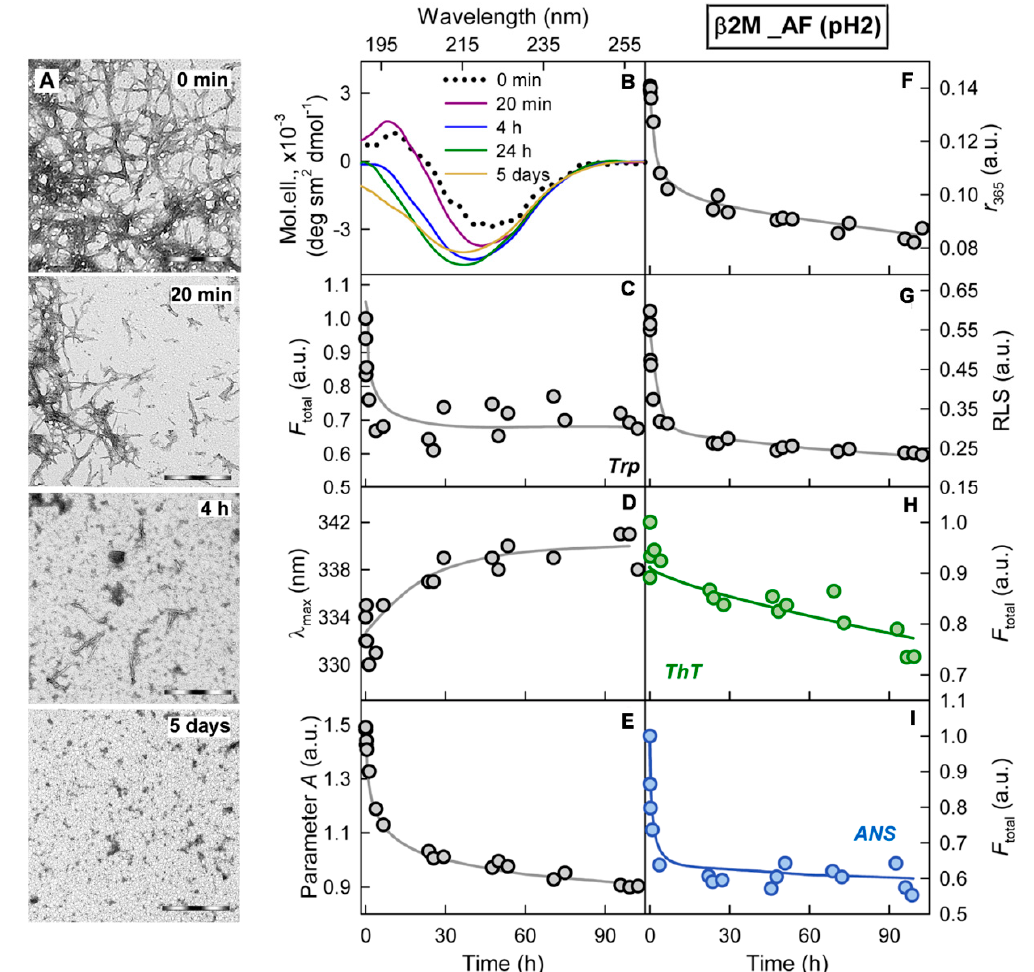
Figure 5. Trypsin-induced degradation of amyloid fibrils formed from beta-2-microglobulin ( β 2M) at pH 2. ( A ) The electron micrographs of amyloid fibrils in the absence and at different time points after the addition of trypsin to the samples. Scale bars are equal to 1 µ m. ( B ) Changes in far UV CD spectra of amyloid samples. ( C ) Changes in total fluorescence intensity of amyloid fibrils at the excitation wavelength of 295 nm. ( D ) Changes in wavelength of the fluorescence spectrum maximum of amyloid fibrils ( λ max ). ( E ) Changes in parameter A of amyloid fibrils, λ ex = 295 nm. ( F ) Changes in fluorescence anisotropy of amyloid fibrils, λ ex = 295 nm, λ em = 365 nm. ( G ) Changes in Rayleigh Light Scattering of amyloid fibrils. ( H ) Changes in the total fluorescence intensity of ThT and ( I ) ANS in the presence of amyloid fibrils. The values at the panels ( C , H , I ) are normalized to the values for fibrils in the absence of the protease. The experiments were conducted under physiological conditions (pH 7.4) and weight ratio of fibrils to trypsin was kept at 125:1. The measurements were performed in 20 mM sodium phosphate buffer solution (pH 7.4). The standard error of the mean is determined for a confidence interval of 0.95 and does not exceed 10%.